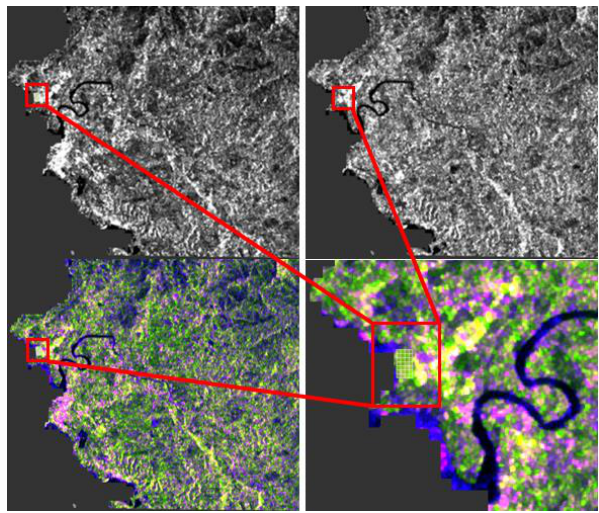
Figure 4. 𝜎˚ 𝑉𝑉 , 𝜎˚ 𝑉𝐻 , RGB ( 𝜎˚ 𝑉𝑉 , 𝜎˚ 𝑉𝐻 , 𝜎˚ 𝑉𝑉 /𝜎˚ 𝑉𝐻 ), and zoomed to plot images (left to right) of the sparse mangrove forest area.